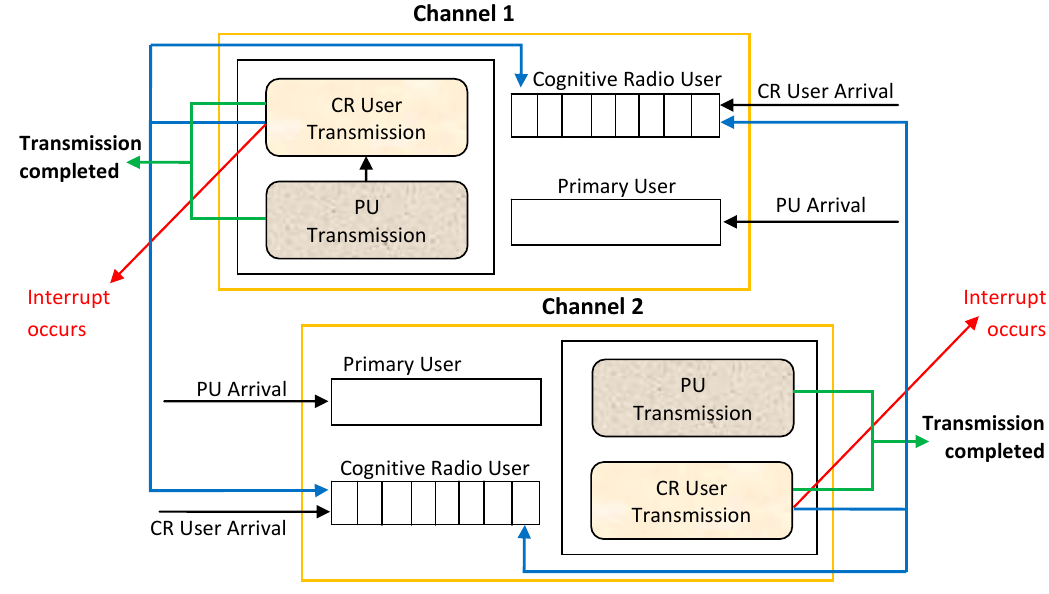
Figure 3. Queuing behavior of cognitive radio user (CRUs) and PUs (two channels and two queues).